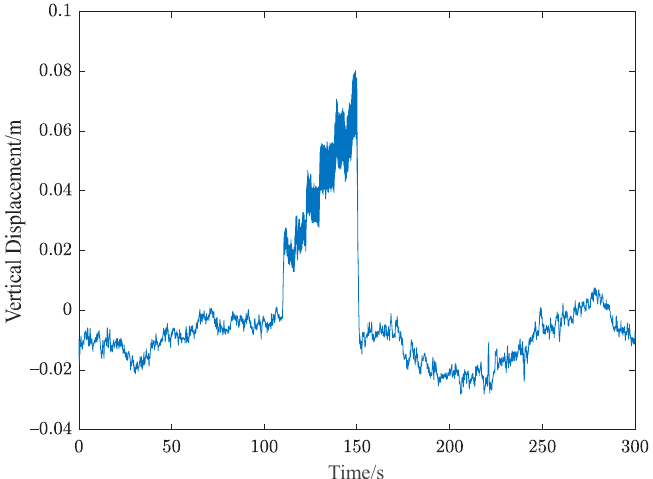
Figure 6. Suntuan River Bridge vertical displacement of GNSS/accelerometer fusion after adding gross errors.